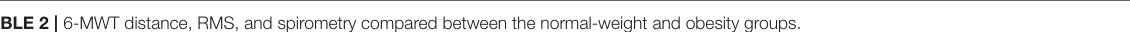
TABLE 2 | 6-MWT distance, RMS, and spirometry compared between the normal-weight and obesity groups. Pulmonary function variables